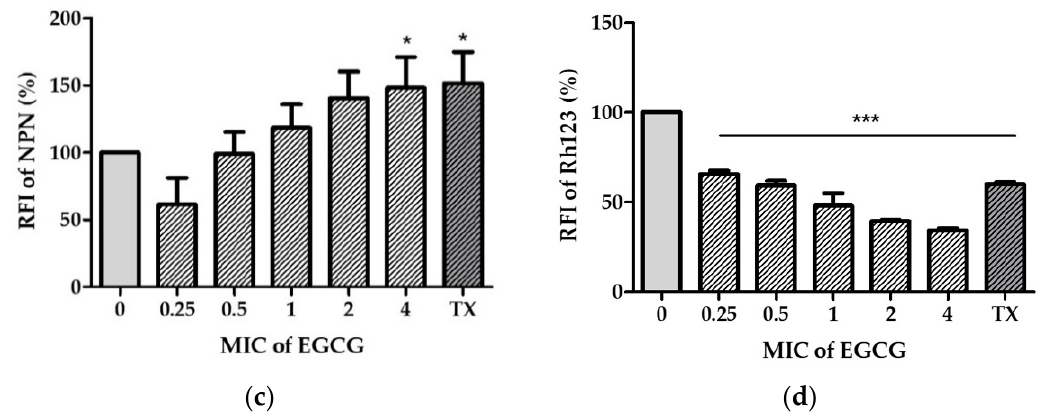
Figure 2. Effect of EGCG on membrane permeability. V. cholerae N16961 was treated with EGCG at concentrations of 0.25× MIC to 4× MIC for 2 h at 37 °C. Intracellular leakage of nucleotides ( a ) and proteins ( b ) were measured, and 0.1% Triton X-100 (TX) was used as a positive control. The outer membrane disruption and membrane potential dissipation were investigated in terms of the Relative Fluorescence Intensity (RFI) percentages of NPN ( c ) and Rh123 ( d ). Significant differences compared to untreated controls are indicated by asterisks: * p < 0.05, ** p < 0.01, *** p < 0.001.